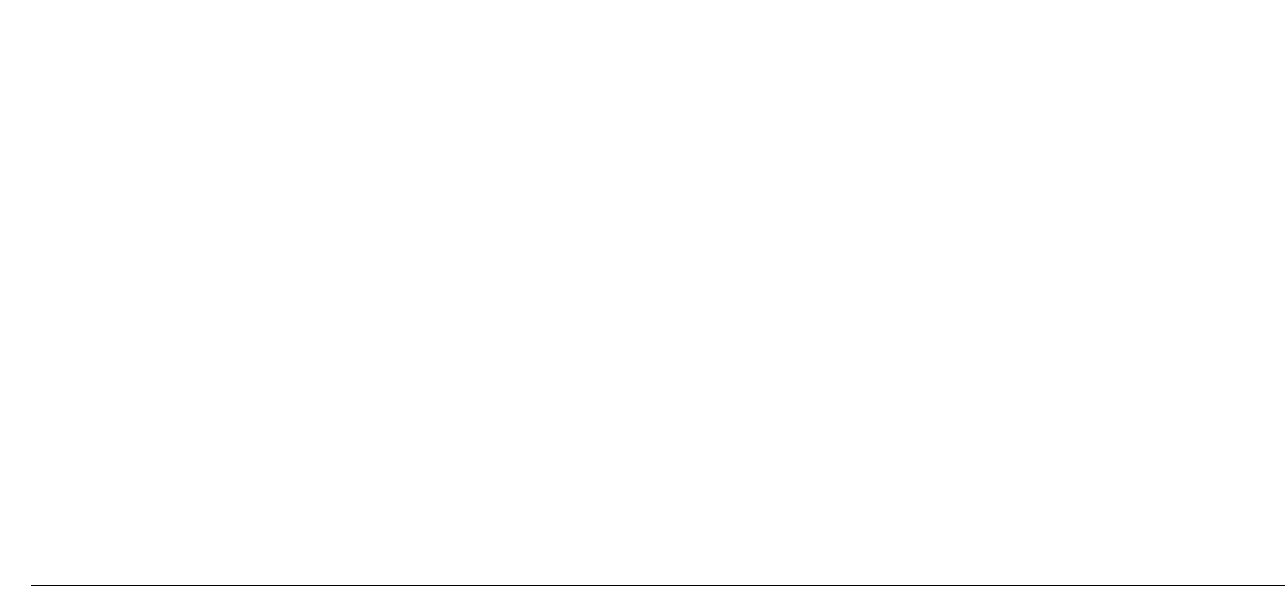
FIGURE 1 |The effects of SCFA-derivative butyrylhydroxamic acid on epithelial cell responses in Caco-2 enterocytes . Cells were left either unstimulated (A) or stimulated with IL1 β (10ng/mL for 24h); (B) , in the presence of indicated butyrylhydroxamic acid concentrations. Secreted levels of IL-8 and CCL-2 were measured and plotted as percentages to vehicle treated unstimulated cells [veh graph (A)